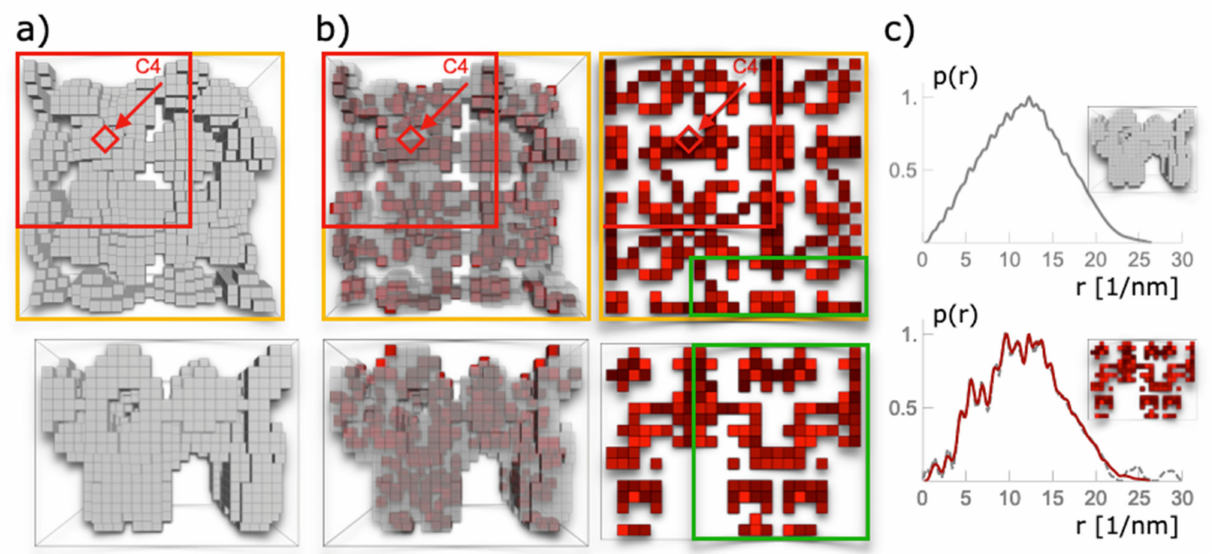
Figure 4. The coarse-grained box model’s refinement. ( a ) Coarse-grained box model, top (top panel) and side view (lower panel). ( b ) Each box is weighted by a factor between 0 and 1. The higher the value, the more the individual box contributes to the pair density distribution. Only boxes with weights higher than 0.3 (light red) are shown. Dark red corresponds to weights close to 1. ( c ) Top panel: pair density (grey line) of the box model (see insert). Bottom panel: pair density (red line) of the weighted box model. The dashed grey line represents pair density that gives the best fits to the experimental scattering